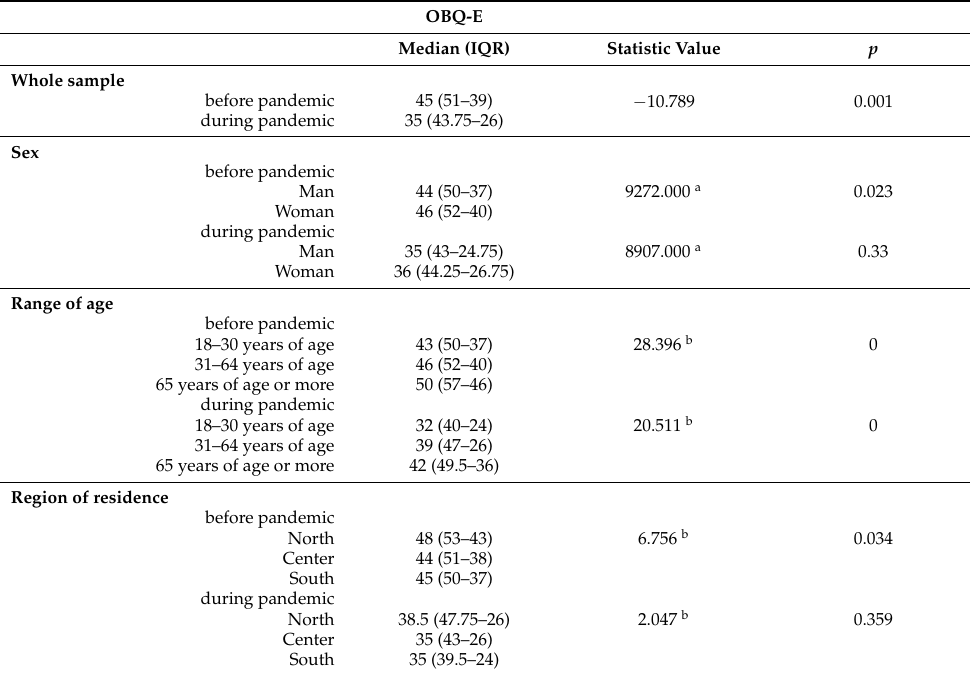
Table 2. Analysis of differences between independent samples in EuroQol 5D-5L and Occupational Balance